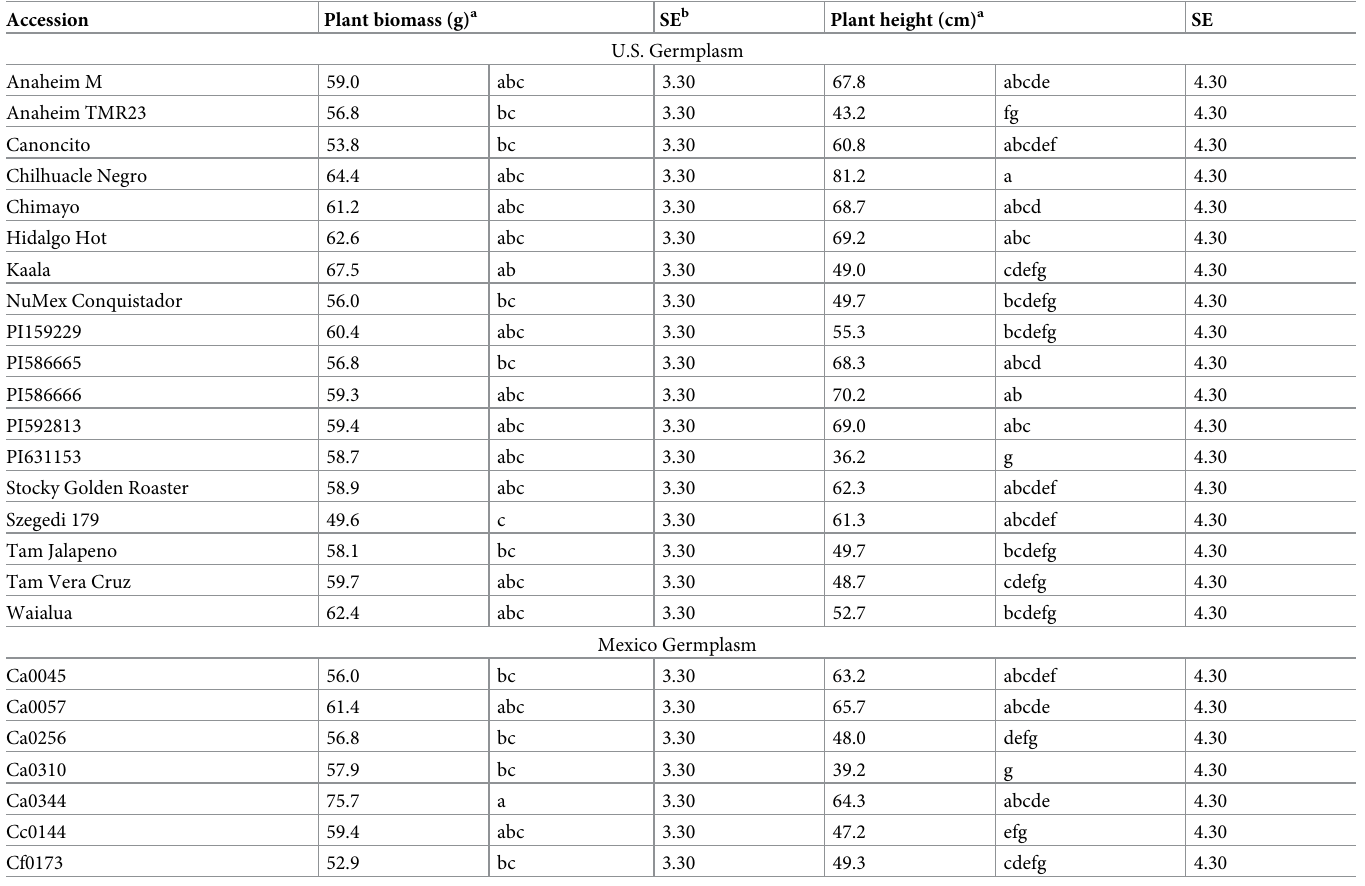
a Different letters indicate significant differences by Tukey’s HSD Test (P = 0.05) between accessions. b Indicates standard error of the